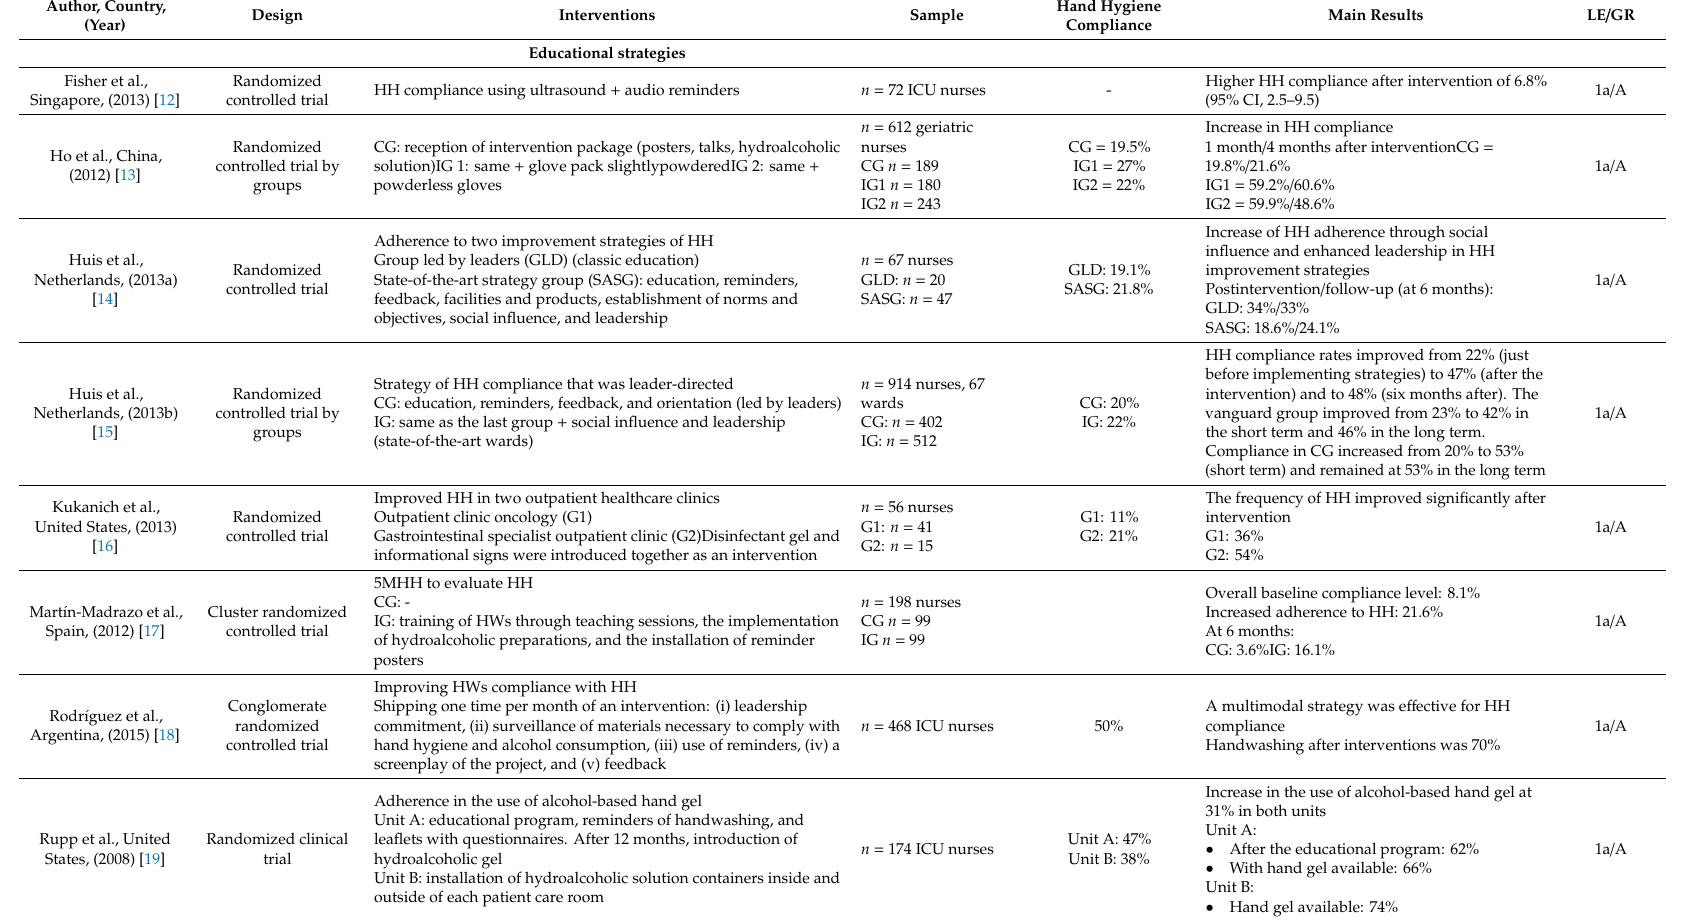
Table 1. Characteristics of included studies ( n =